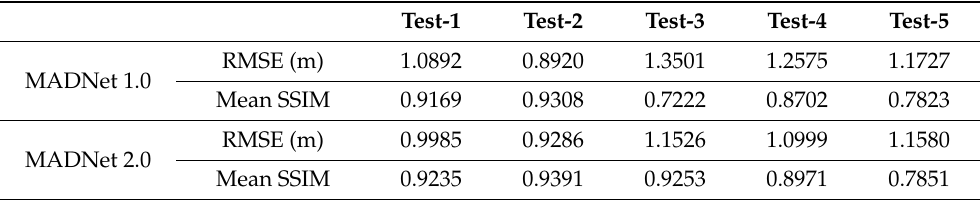
Table 1. RMSEs and mean SSIMs of the MADNet 1.0 and MADNet 2.0 test results with respect to the PDS ground-truth for the five exemplar areas that are shown in Figure